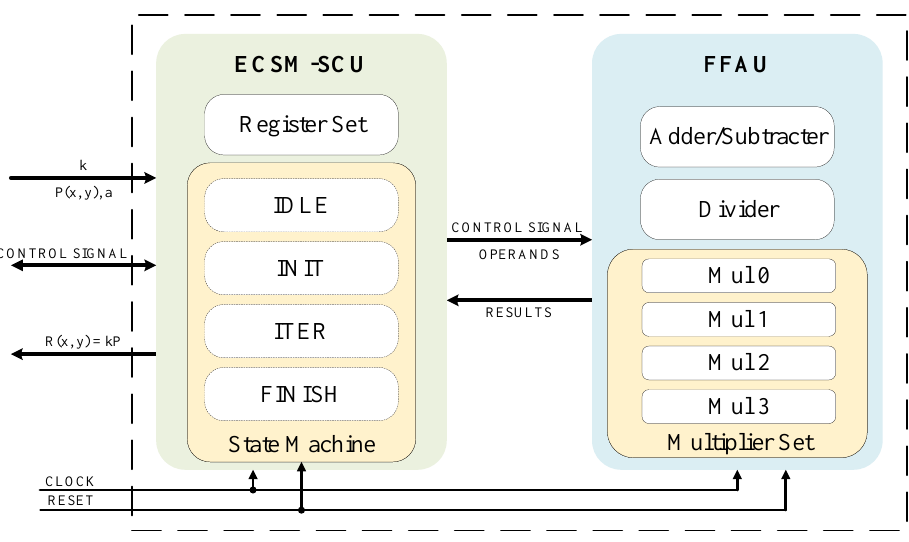
Figure 8. Proposed ECSM